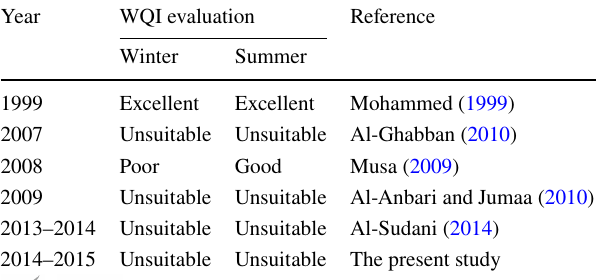
Fig. 2 Historical changes in the WQI of Diyala River Table 5 The historical evaluation of WQI of Diyala